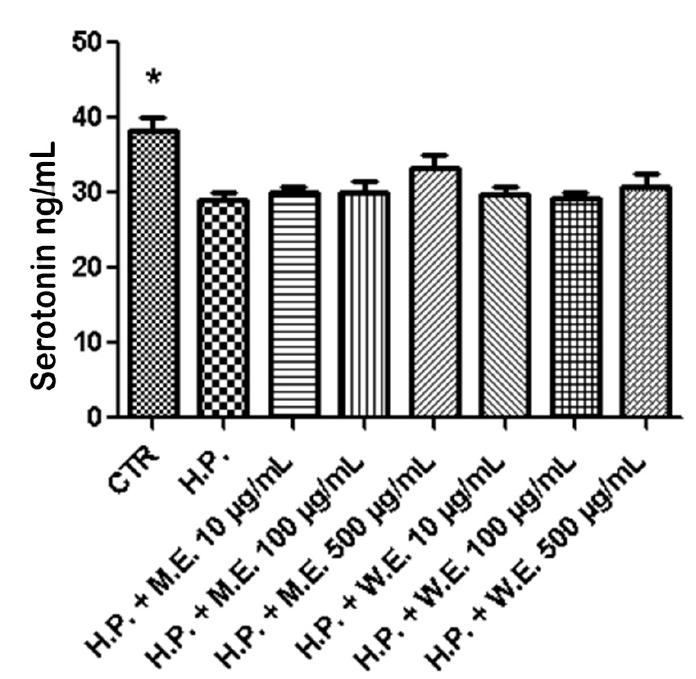
Figure 5. E ff ects of P. foetida methanol (M.E.) and water (W.E.) extracts on hydrogen peroxide 300 µ M (H.P.)-induced decrease of serotonin (5-HT) release from hypothalamic HypoE22 cell. 5-HT release was quantified through HPLC coupled to coulometric detection and expressed as ng / mL. Data were analyzed through analysis of variance (ANOVA), followed by post hoc Newman-Keuls test. ANOVA, p < 0.05; * p < 0.05 vs. H.P.